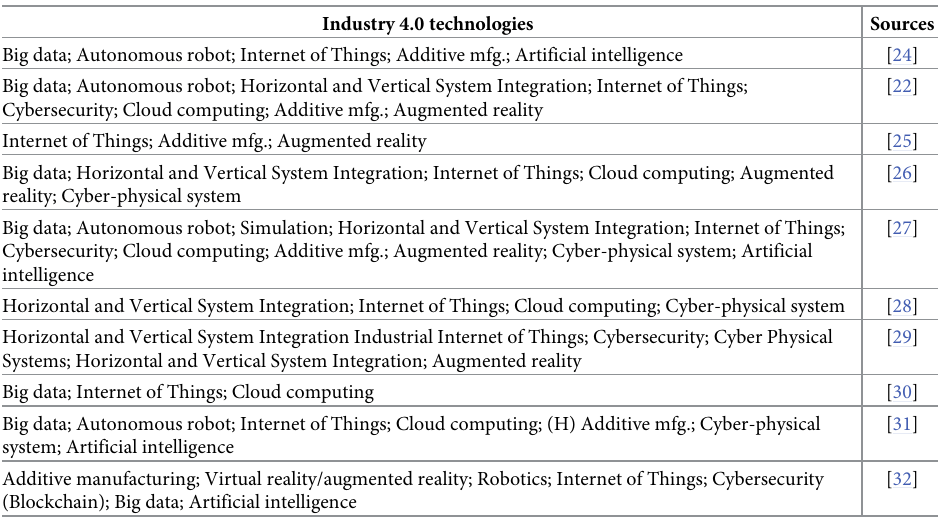
Table 1. Industry 4.0